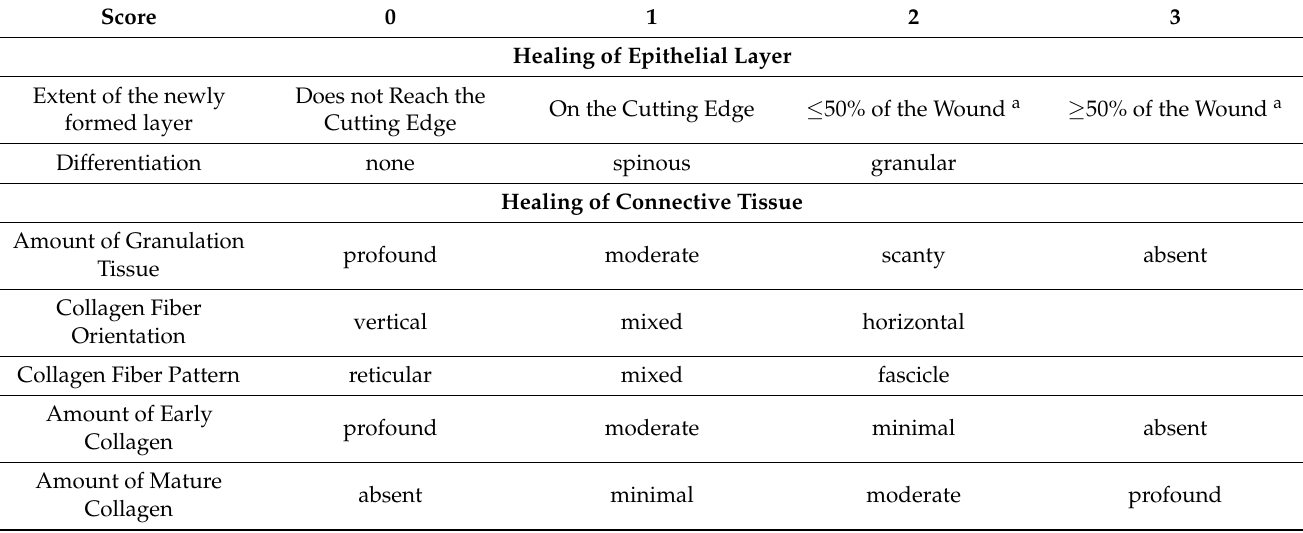
Table 2. Histopathological parameters of wound